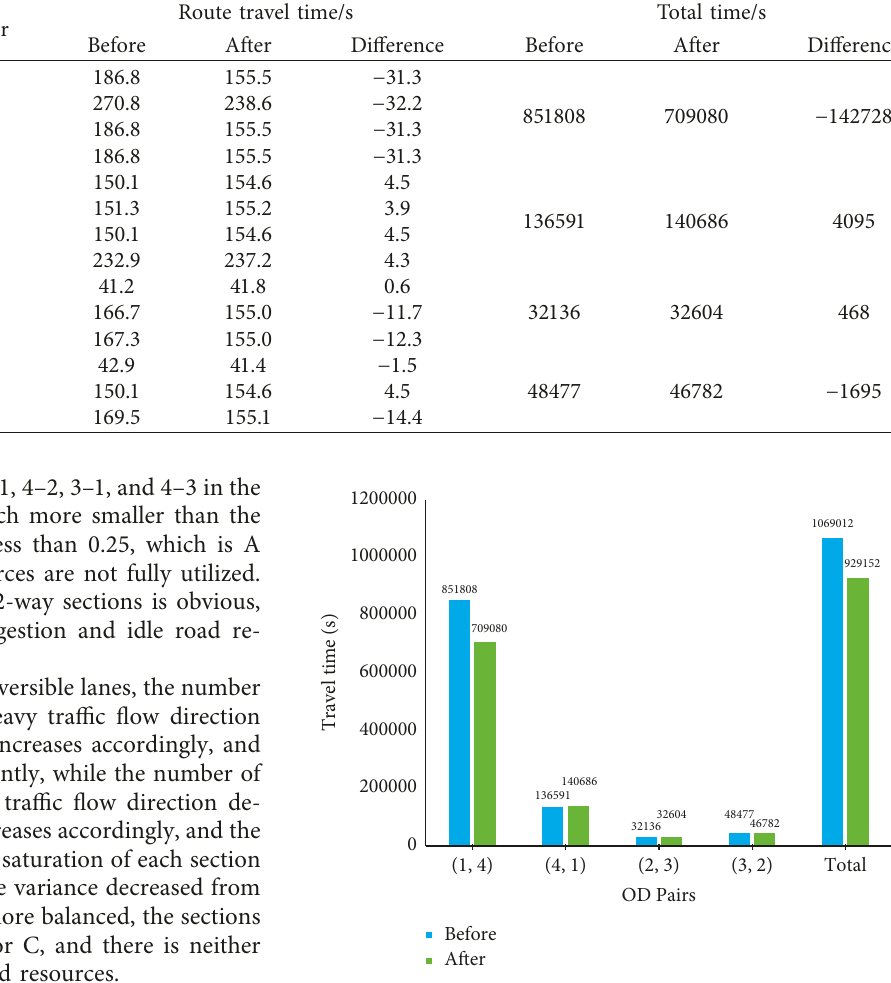
Figure 7: Total travel time of the system and between OD pairs before and after